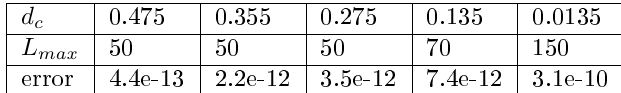
Tab. 1: The absolute errors of